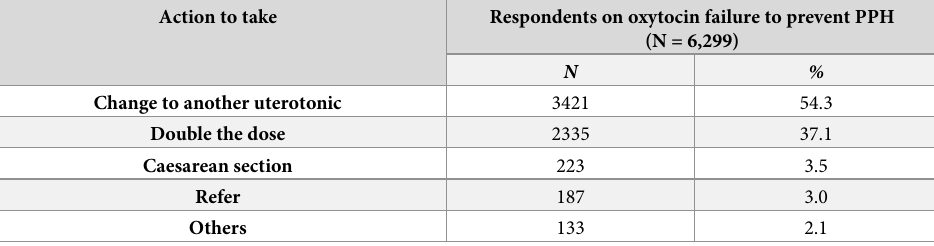
Table 8. Respondents’ action following oxytocin failure to prevent PPH. Action to take